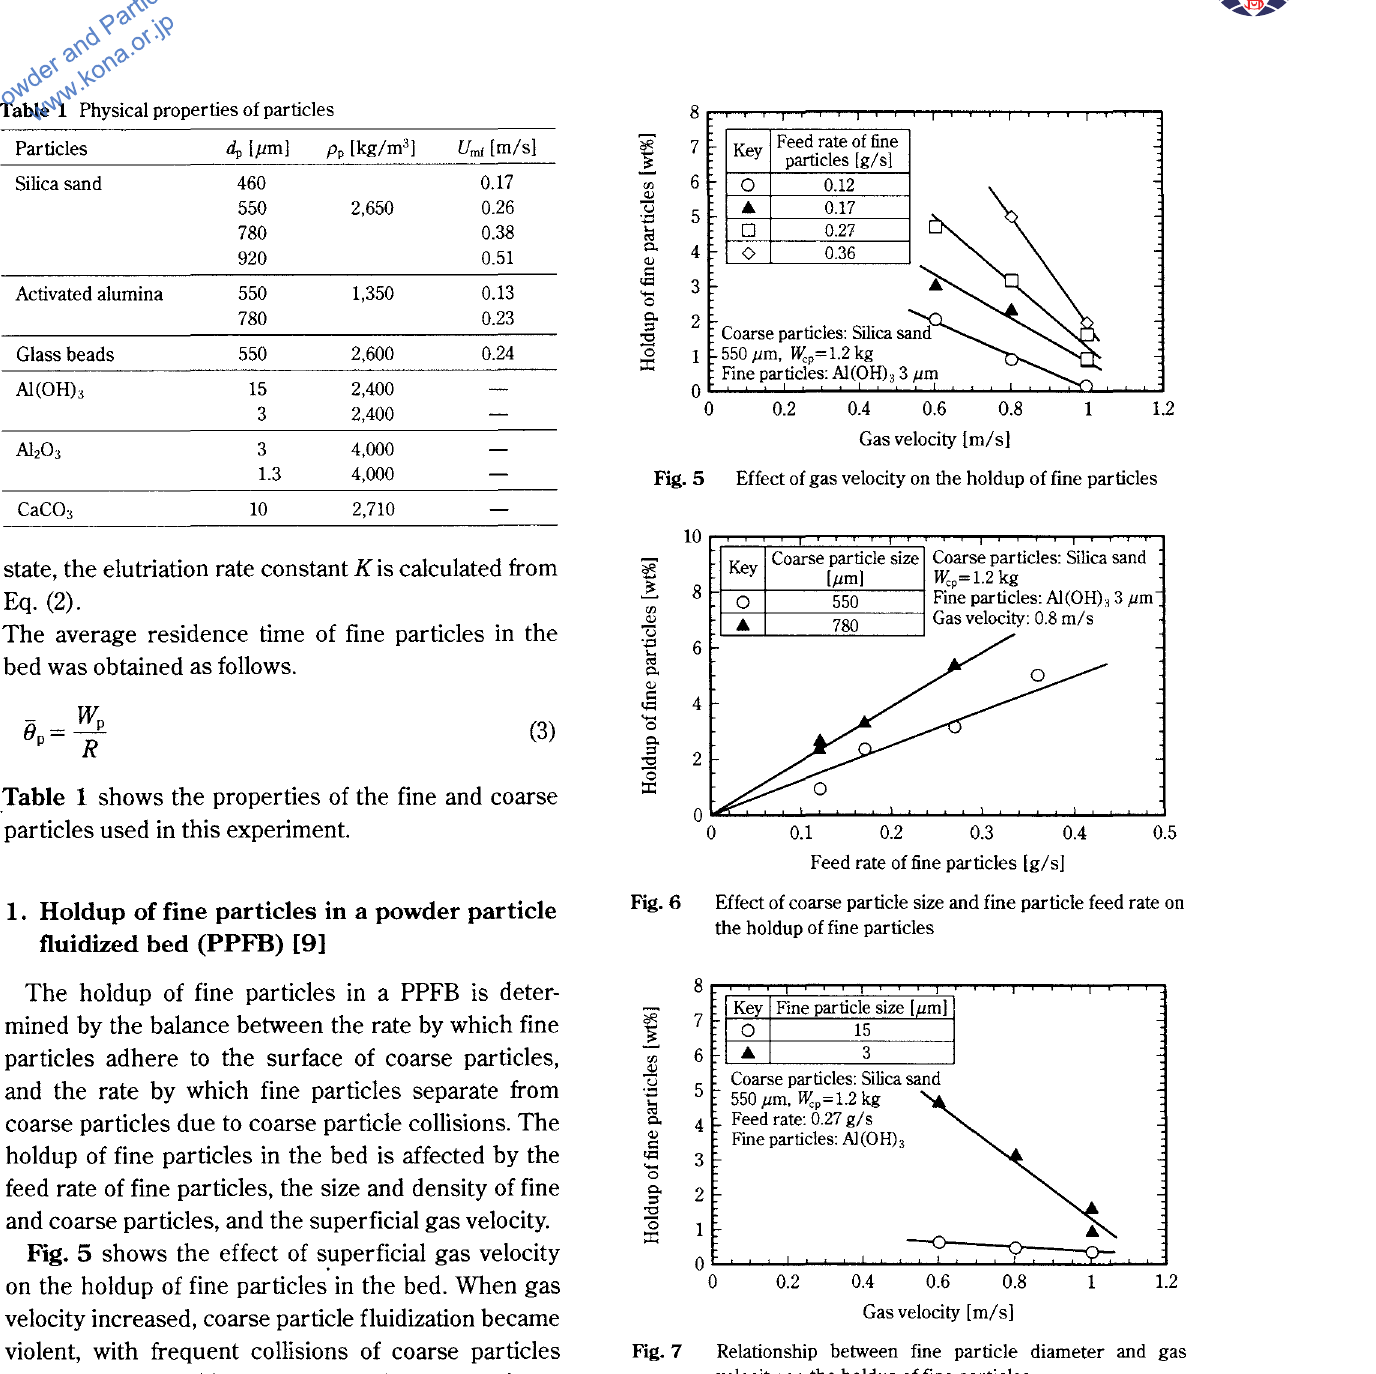
shows that when fine particle size decreased, their holdup in the bed increased remarkably. When fine particle size was small, the force by which fine parti cles adhered to coarse particles became large, and holdup increased greatly. In a powder particle fluidized bed, fine particles are present in the bed in the following three